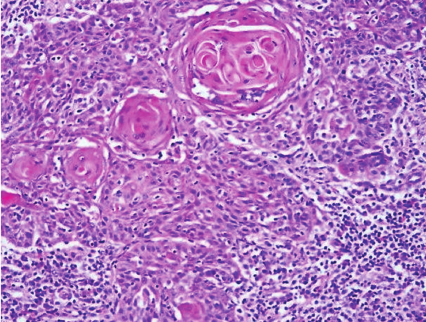
Figure 2: Histopathology of left supraclavicular node showing metastatic squamous cells with abundant eosinophilic cytoplasm and cell keratinization.